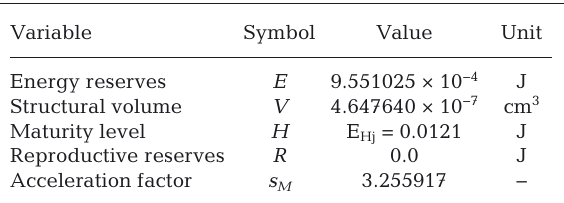
structural volume (V) on December 31, 2019. We chose V as a proxy of growth (in length or weight). V is less sensitive than the overall energy content or flesh mass to the feeding condition and spawning phenol- ogy and thus displays a more monotonic trend.